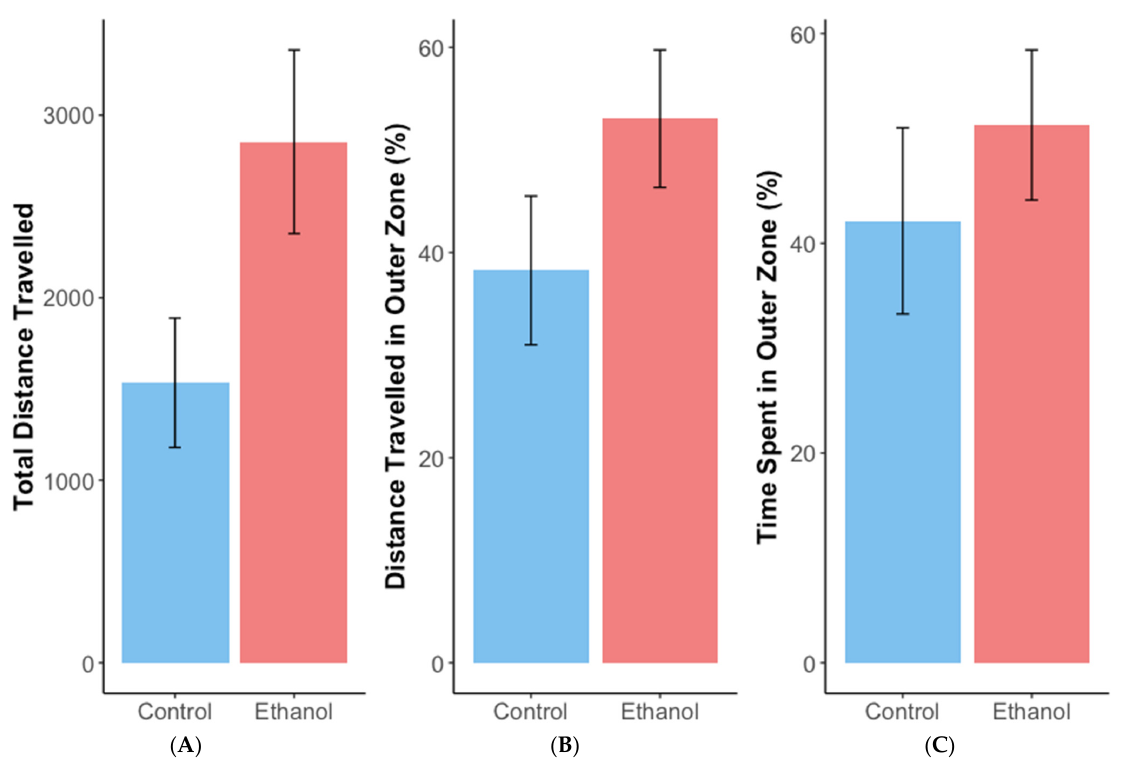
Figure 2. Mean (+/ − SE) total distance travelled ( A ), and distance travelled ( B ) and time spent ( C ) in the outer zone as a percentage of the total for adult female zebrafish during the open field test after exposure to 1% ethanol or water (control). n = 14 for the control and 14 for the ethanol-treated fe- males. 3.2. Hormone Responses of Larvae of Ethanol-Treated and Control Females to a Stressor Offspring of control females exhibited significantly higher levels of whole-body cor- tisol when exposed to the alarm cue (df = 32, p < 0.05), as predicted (Figure 3). However, exposure of ethanol-treated mothers’ offspring to alarm cue had no significant effect on larval cortisol levels (df = 32, p = 0.57), and in fact they had an elevated cortisol level that was similar to the control alarm cue response. There was no interaction between maternal treatment and response to alarm substance (df = 32, p = 0.13).